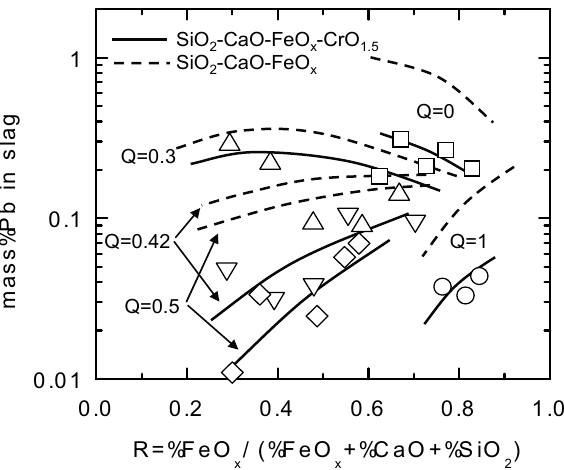
Figure 4. Lead solubility in the FeO x -CaO-SiO 2 -CrO 1:5 slag with iron saturation at 1573